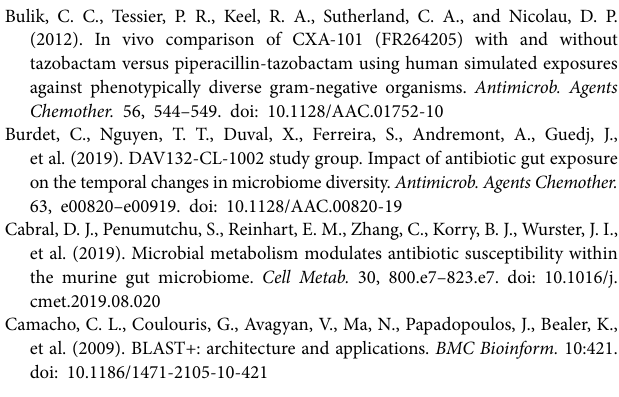
Supplementary Figure 1 | Bacterial quantification of the TZP1 experiment. Box and whiskers plots show the fold change of the 16S rRNA gene count as generated by qPCR from DNA extracted from stool for all mice at each time point as compared to Day 8, the timepoint immediately prior to antibiotic treatment. Supplementary Figure 2 | PCoA of taxonomic profiles and immune status. PCoA analysis based on the Bray-Curtis distance matrix of OTUs from TZP2. Each circle represents a single mouse at a single timepoint. Closed circles represent immunocompetent mice and open circles represent neutropenic mice. Supplementary Figure 3 | (A) Phyla profiles. The relative abundance of the phyla is represented by stacked bars for each mouse and each day. (A) Portrays TZP1 in which TZP was administered days 7–13, (B,C) portray immunocompetent mice (mice 1–10) and neutropenic mice (mice 11–20), respectively, from TZP2 in which TZP was administered on days 15–18. (B,C) Phyla profiles. The relative abundance of the phyla is represented by stacked bars for each mouse and each day. (A) Portrays TZP1 in which TZP was administered days 7–13, (B,C) portray immunocompetent mice (mice 1–10) and neutropenic mice (mice 11–20), respectively, from TZP2 in which TZP was administered on days 15–18. Supplementary Figure 4 | (A) Genera profiles. The relative abundance of genera is represented by stacked bars for each mouse and each day. The top 25 genera are colored individually and all other genera are assigned to the “Other Taxa” group (light gray). (A) Portrays TZP1 in which TZP was administered days 7–13, (B,C) portray immunocompetent mice (mice 1–10) and neutropenic mice (mice 11–20), respectively, from TZP2 in which TZP was administered on days 15–18. (B,C) Genera profiles. The relative abundance of genera is represented by stacked bars for each mouse and each day. The top 25 genera are colored individually and all other genera are assigned to the “Other Taxa” group (light gray). (A) Portrays TZP1 in which TZP was administered days 7–13, (B,C) portray immunocompetent mice (mice 1–10) and neutropenic mice (mice 11–20), respectively, from TZP2 in which TZP was administered on days 15–18. Supplementary Figure 5 | (A) Potentially Resistant OTUs. OTUs that underwent a positive fold change of relative abundance post-TZP exposure are shown for each experiment ( A,B , TZP1 and TZP2, respectively). Fold change was calculated compared to the last pre-antibiotic time point (Days 6 and 14, respectively). The vertical line indicates the approximate first TZP exposure. (B,C) Potentially resistant OTUs. OTUs that underwent a positive fold change of relative abundance post-TZP exposure are shown for each experiment ( A , B , TZP1 and TZP2, respectively). Fold change was calculated compared to the last pre- antibiotic time point (Days 6 and 14, respectively). The vertical line indicates the approximate first TZP exposure. Supplementary Figure 6 | Piperacillin concentrations in mouse feces during and post-TZP exposure. Supplementary Figure 7 | Piperacillin concentrations in mouse feces during and post-TZP